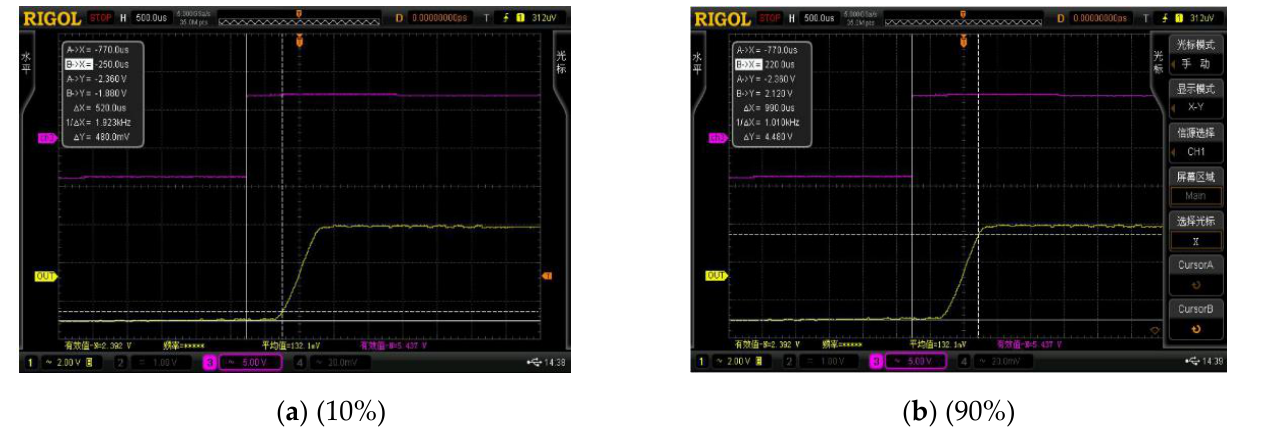
Φ 1 Figure 22. The schematic diagram of Leakage current detection. Figure 22. The schematic diagram of Leakage current detection.